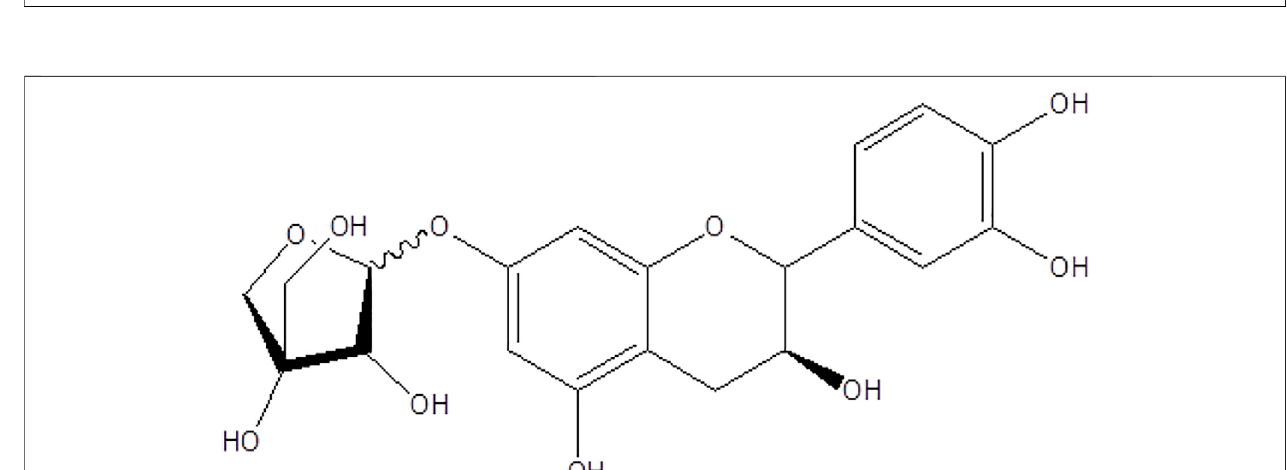
FIGURE 2 | Scheme of extraction of USCFR and USCFREA.